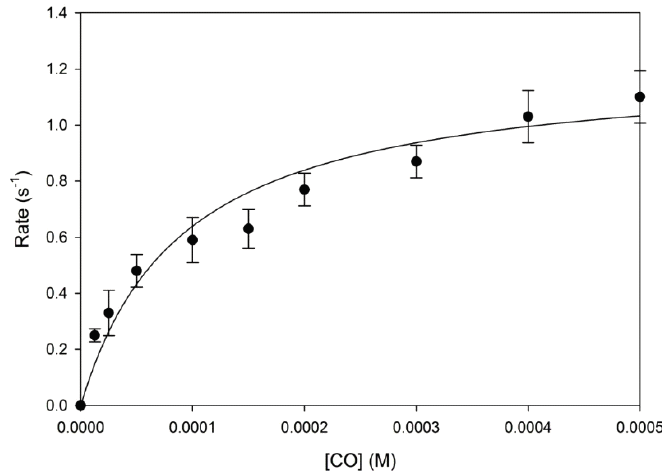
Figure 1. Concentration dependence of carbon monoxide binding to deoxy-ferrous neuroglobin. Reaction rates observed in stopped-flow experiments are shown as a function of carbon monoxide concentration (points). The data were best-fitted to a hyperbolic function (line r 2 = 0.94). The error bars represent the standard error seen for replicate experiments (different protein preparations used on different days). Technical replicate values fell within the diameter of the